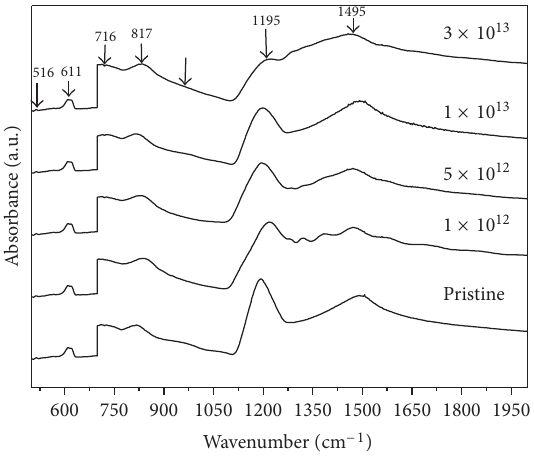
F 9: Showing the FTIR spectra of Ag BBiSA series. 14+ ion.